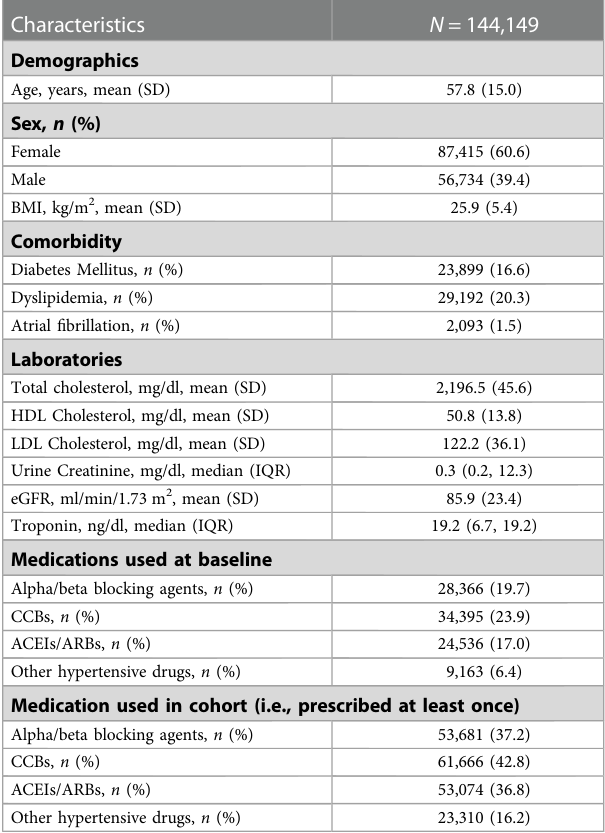
TABLE 1 Baseline characteristics of the hypertensive